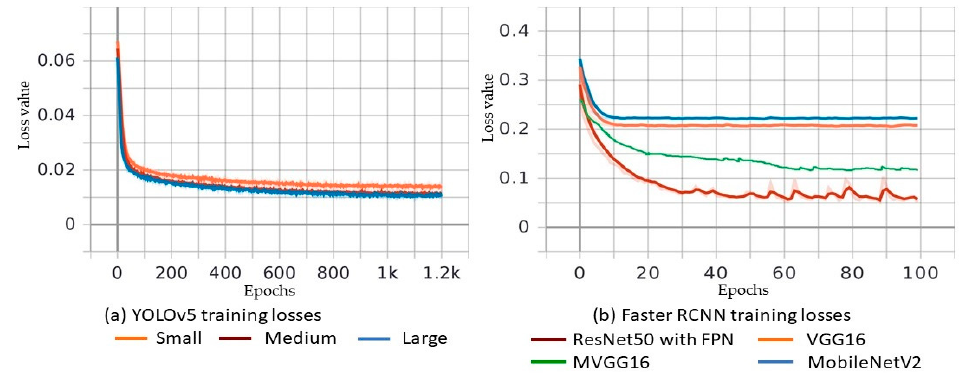
Figure 10. ( a ) Training loss values for YOLOv5 and ( b ) training loss values for Faster R-CNN with four backbones: ResNet50 with FPN, VGG16, MVGG16, and MobileNetV2.